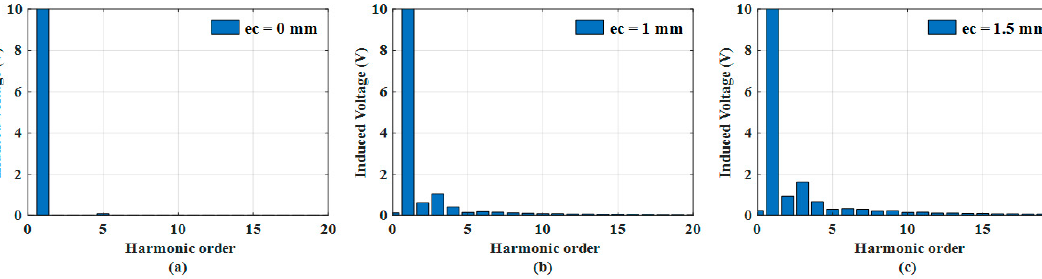
Figure 5. Fast Fourier transform analysis results of back EMF: ( a ) ec = 0 mm, ( b ) ec = 1 mm, and ( c ) ec = 1.5 mm.